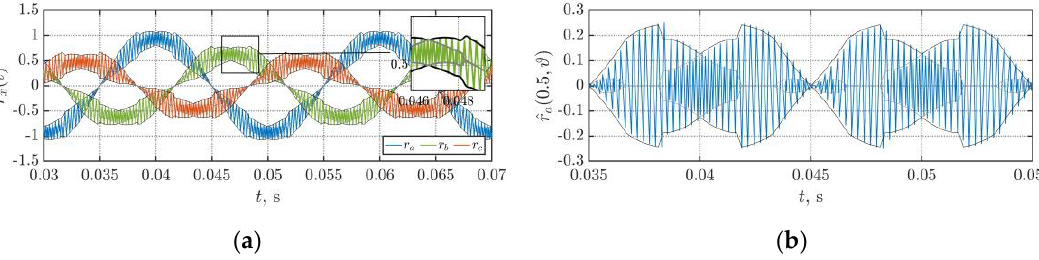
Figure 15. Primary (black) and secondary (gray) envelopes in case of DPWM3 at m = 0.5 and f sw = 3.6 kHz: ( a ) Normalized phase currents; ( b ) Normalized phase current ripple. Current Ripple Peak-to-Peak